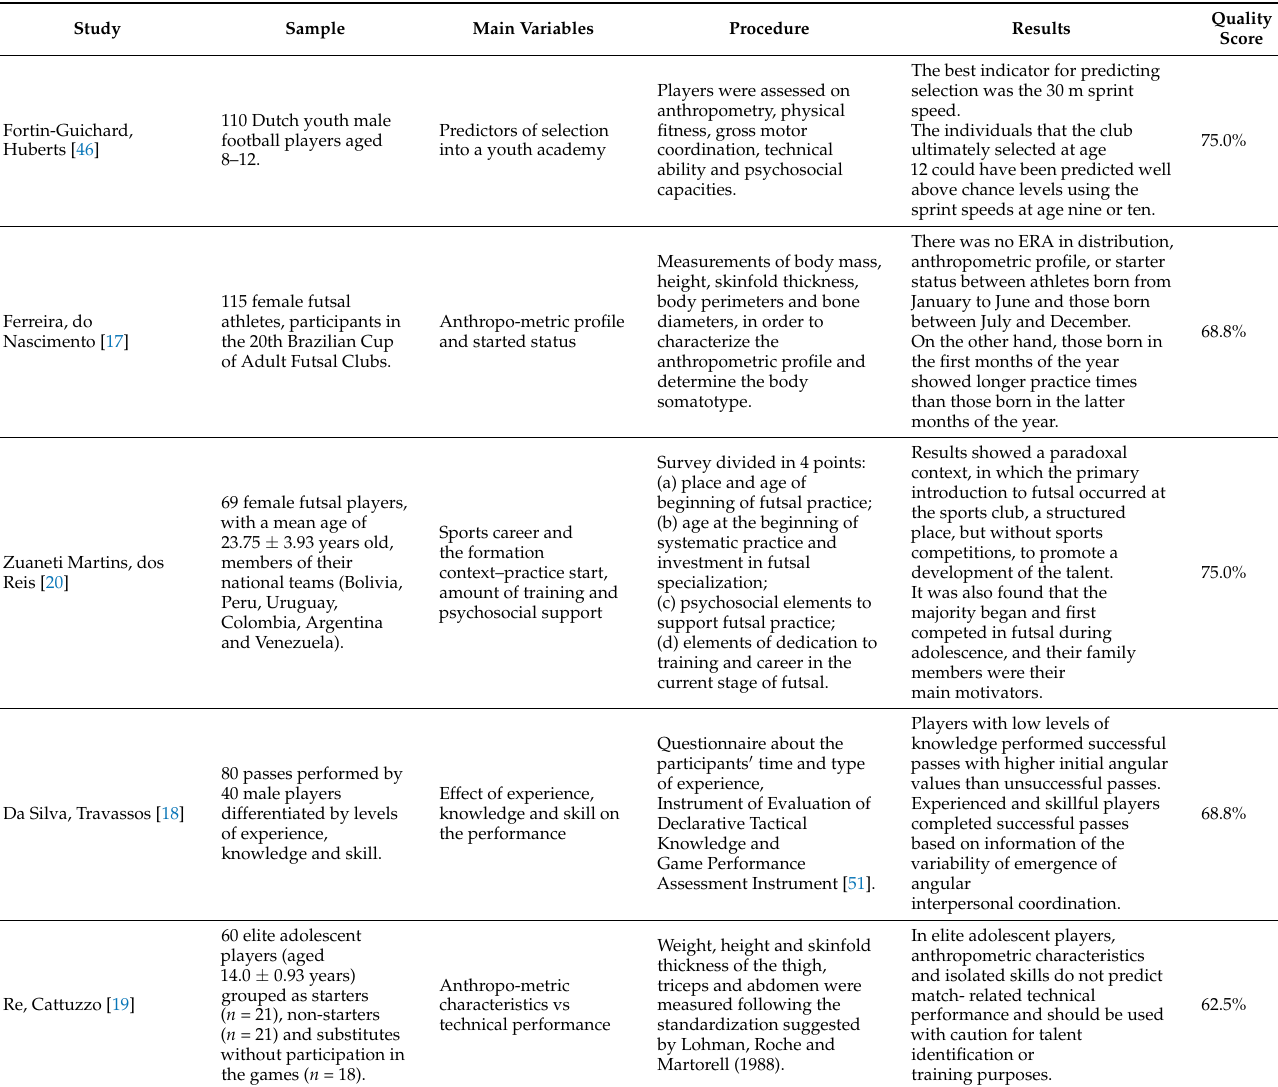
Table 9. Studies with predominantly multidimensional